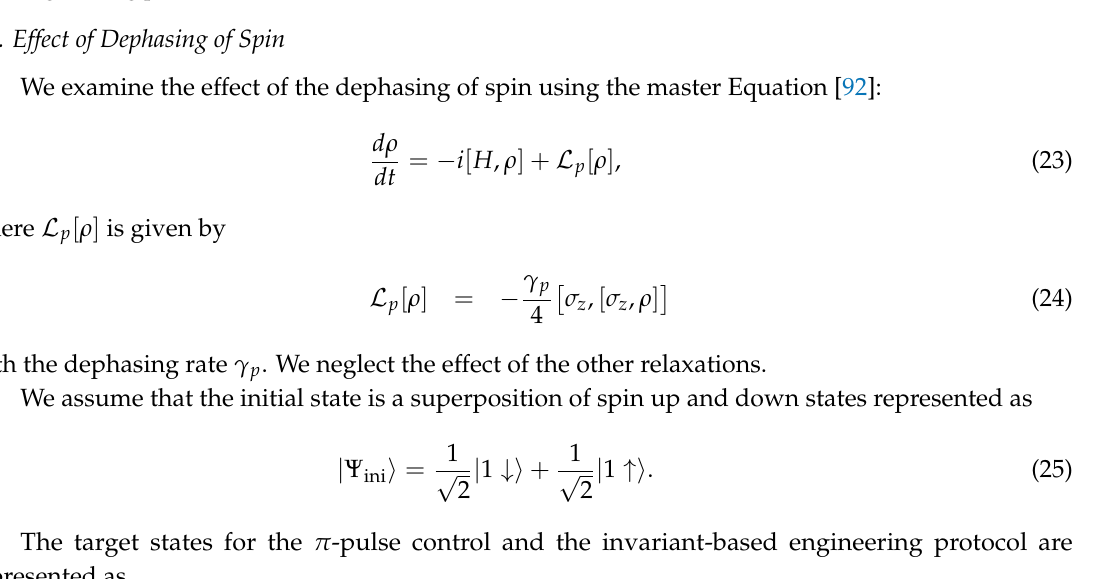
Figure 8. Dependence of the fidelity at t = T stepI on κ for the π -pulse and the invariant-based engineering